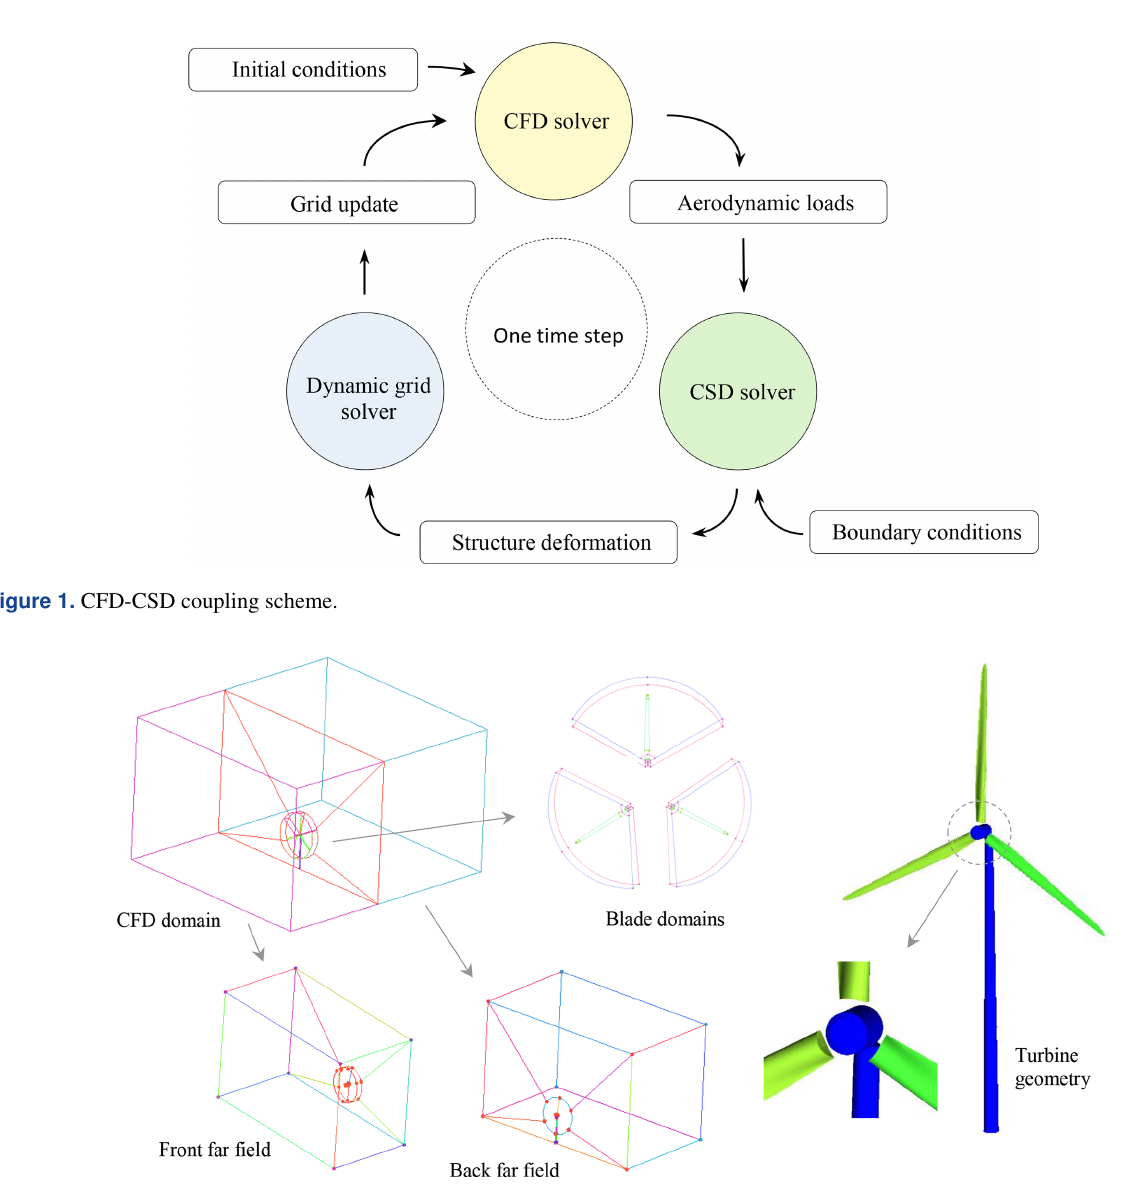
Figure 2. CFD domain and wind turbine